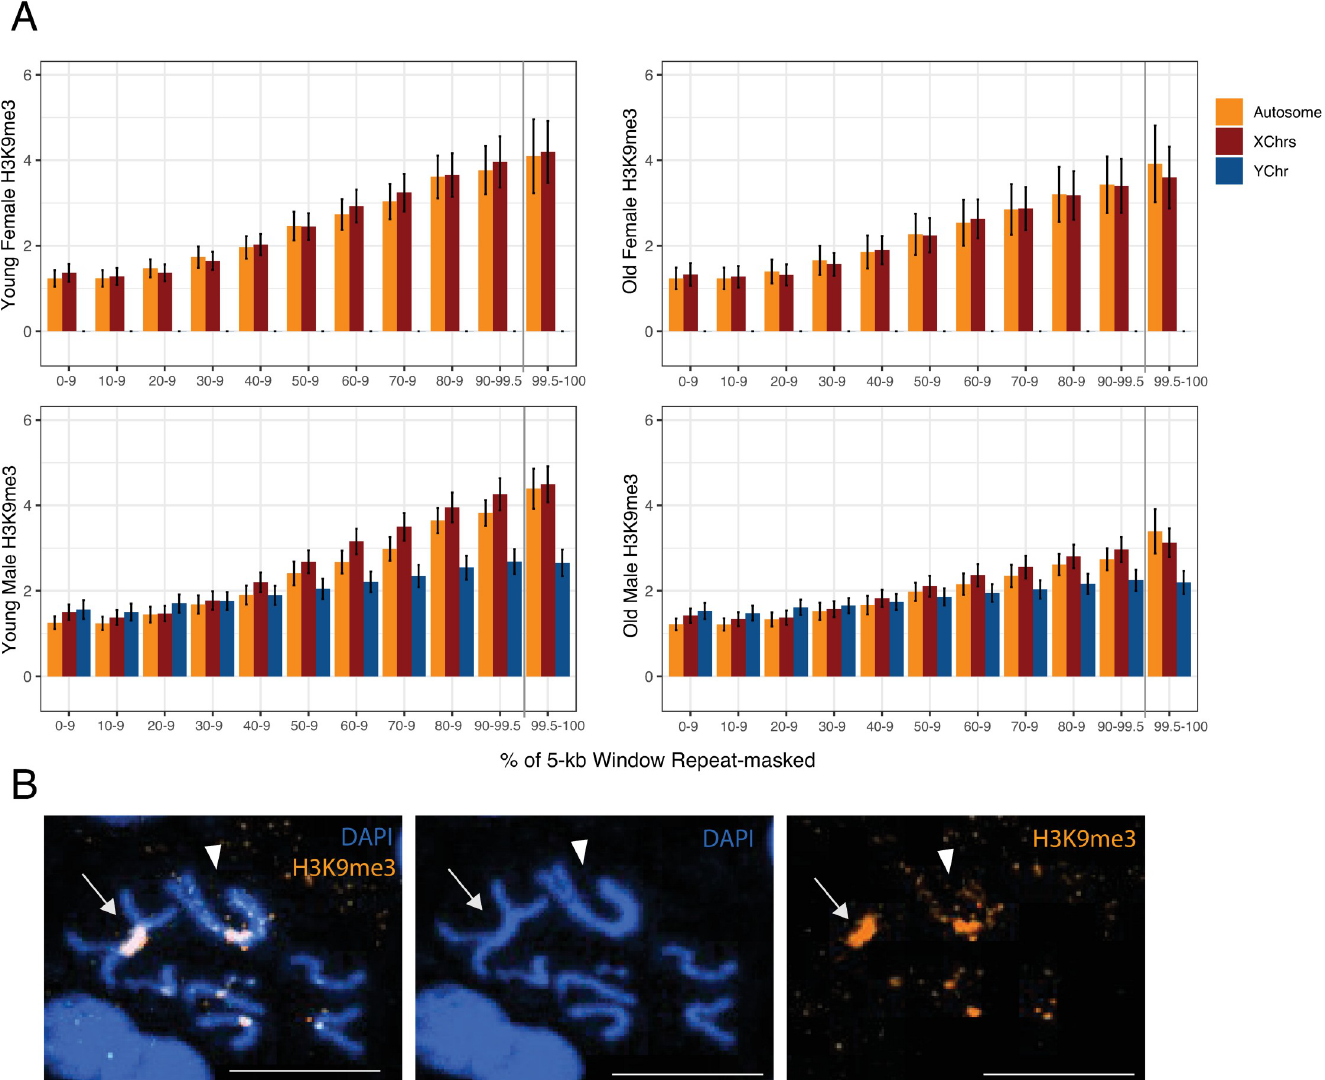
Fig 3. Heterochromatin enrichment across chromosomes. A. ChIP enrichment across samples grouped by chromosome and binned by amount of repeats (%) per 5kb–window. Values represent the mean of 4 replicates with standard error bars with the exception of the “Old Males” where we omit 1 failed ChIP replicate. B. Immunofluorescence staining for H3K9me3 in male mitotic chromosomes. Arrowhead denotes neo-Y, arrow denotes MullerA-AD (old-X), scale bar is 50 μ m.